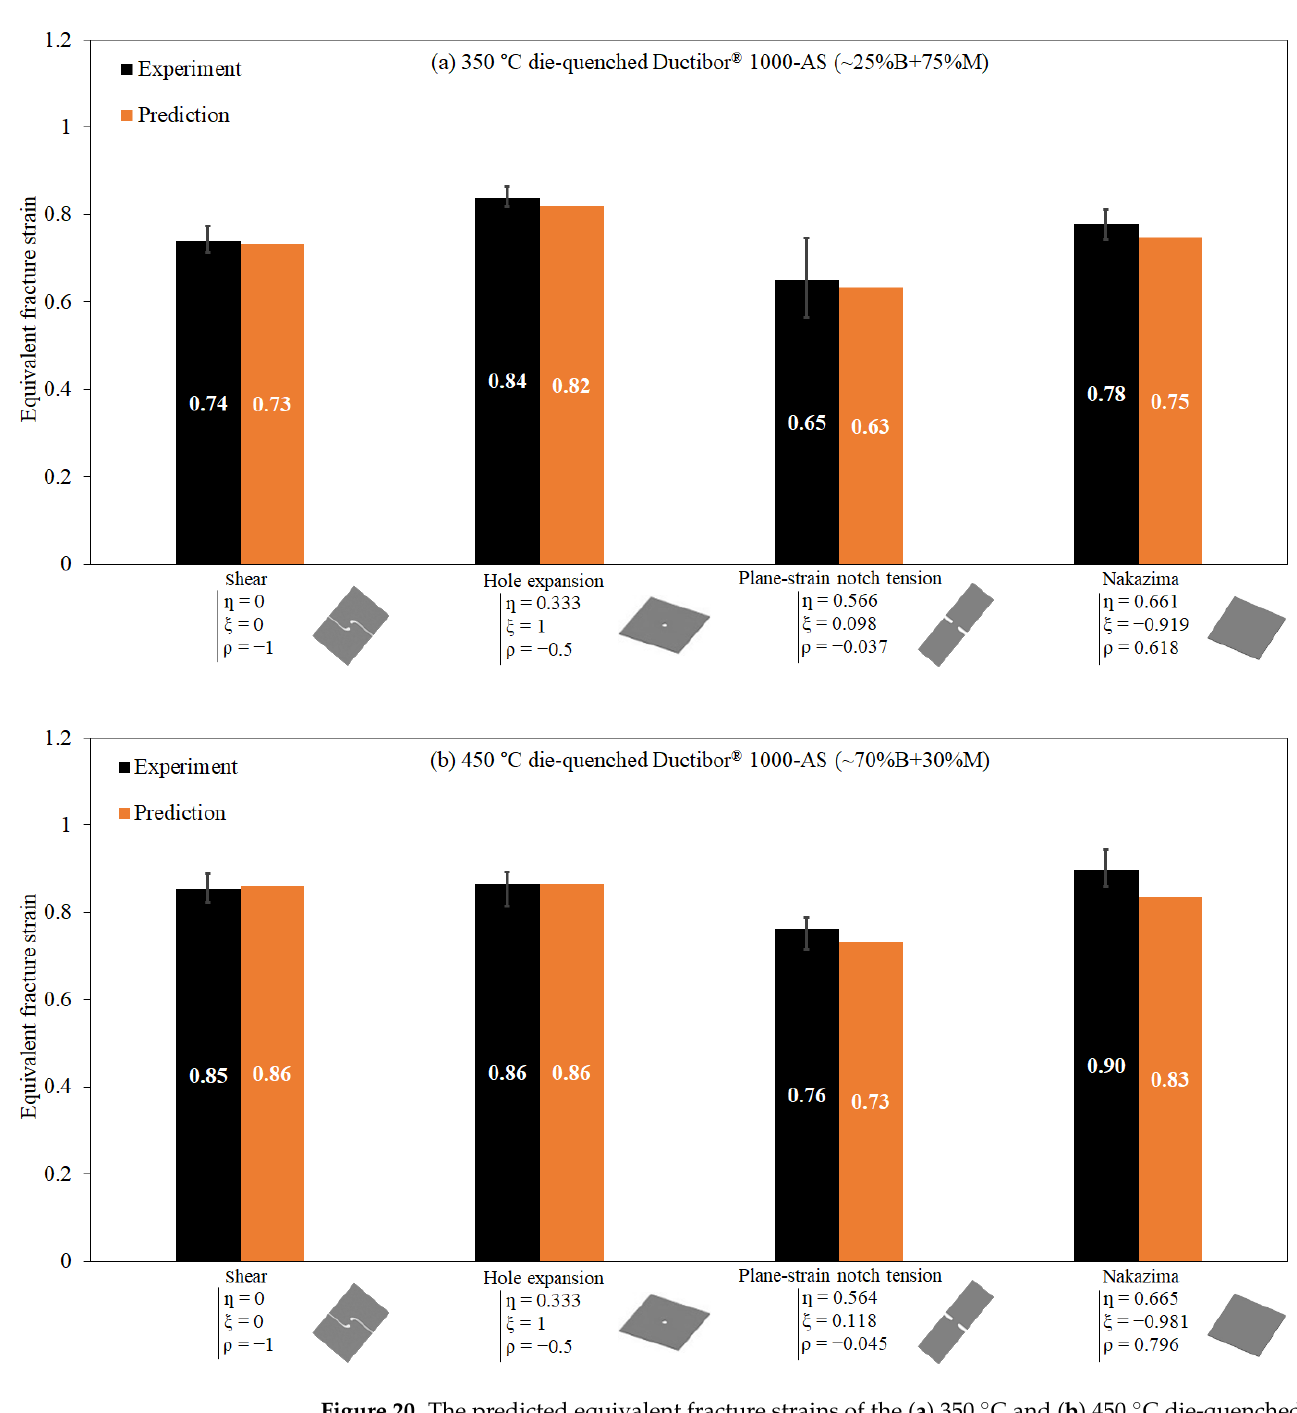
Figure 20. The predicted equivalent fracture strains of the ( a ) 350 ◦ C and ( b ) 450 ◦ C die-quenched microstructures of Ductibor ® 1000-AS in each fracture test using the established numerical scheme. The scatter of the measured data is denoted by the error